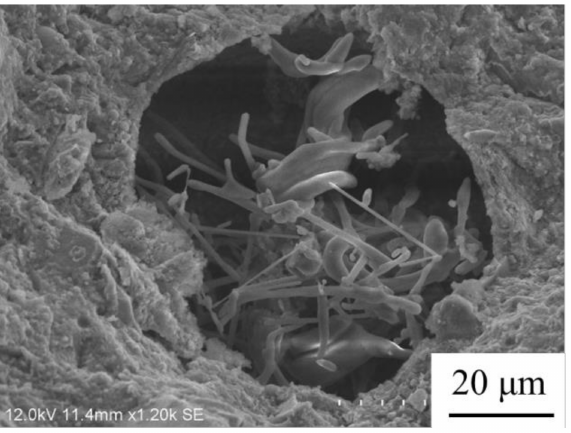
Figure 9. The SEM image of the hydration products of CCCW in